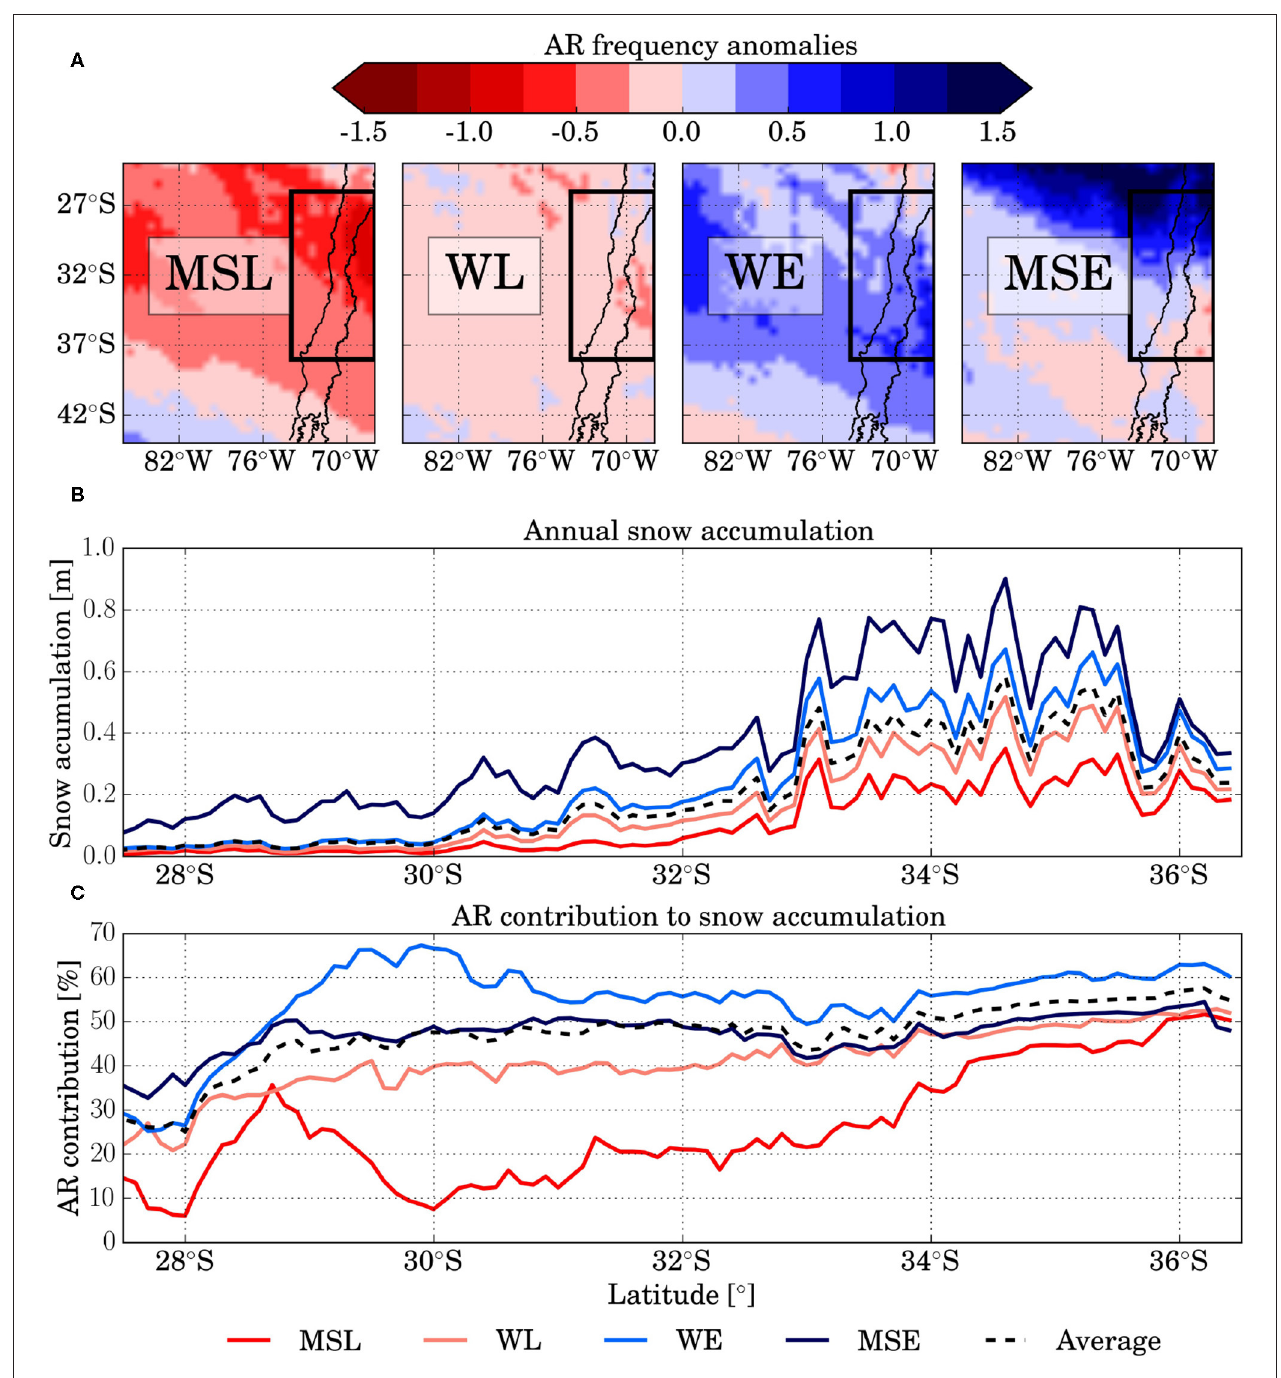
FIGURE 6 | (A) Standardized anomalies of AR frequency for different ENSO phases: moderate to strong La Niña (MSL), weak La Niña (WL), weak El Niño (WE) and moderate to strong El Niño (MSE). The black rectangles delimit the study zone and black lines show coastline and political border between Chile and Argentina. (B) Variation with latitude of latitudinally-averaged snow accumulation for the different ENSO phases and average year. (C) Same as (B) but for AR contribution to the annual snow accumulation.